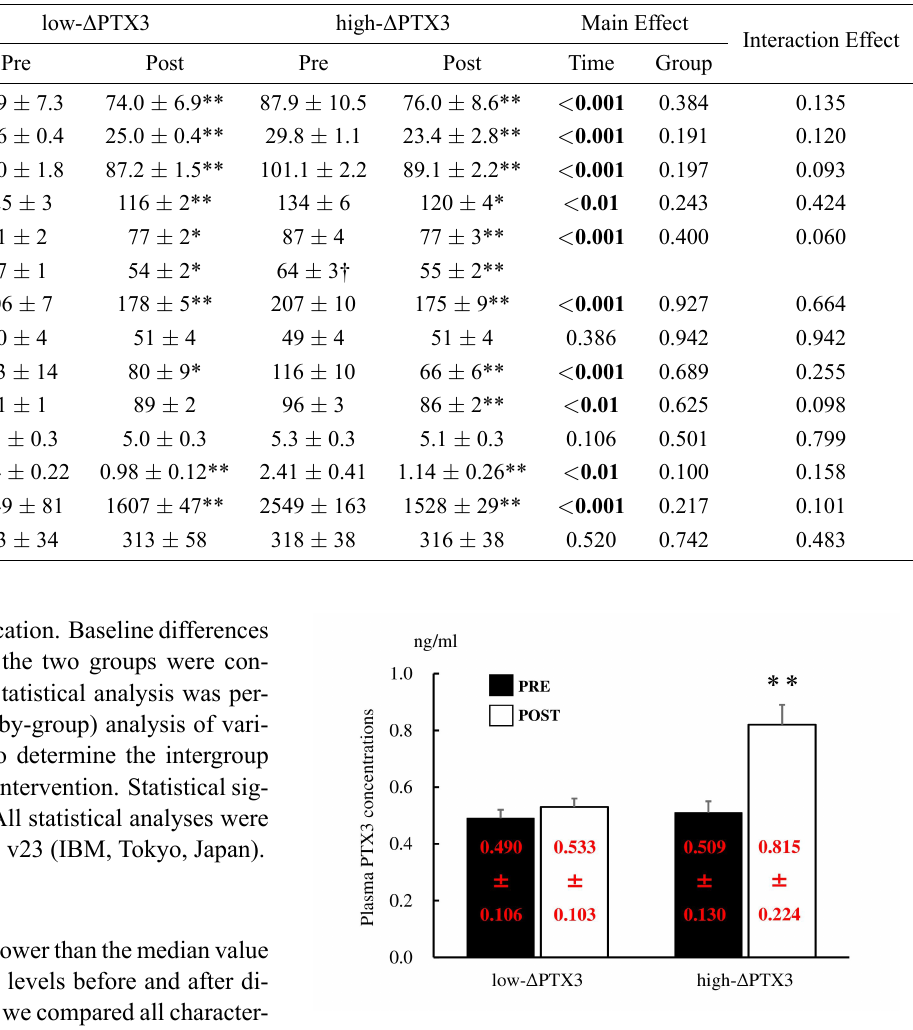
Fig. 1. Changes in plasma PTX3 concentrations before and af- ter dietary modification program in the high and low ∆ PTX3 groups . ** p < 0.01 vs.